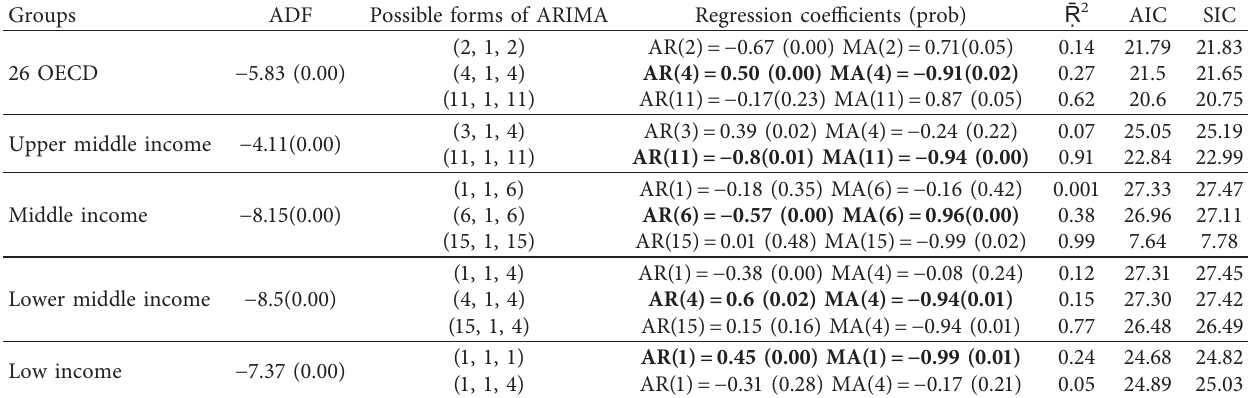
Table 2: Unit root test and ARIMA results for methane emission.